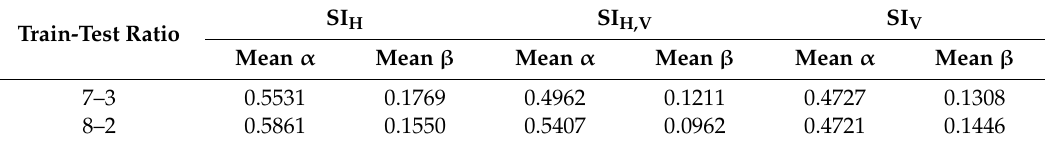
Table 4. Mean parameters α and β over non-overlapping test sets. SI H : only horizontal spatial information, SI H,V : horizontal and vertical spatial information, SI V : only vertical spatial information.